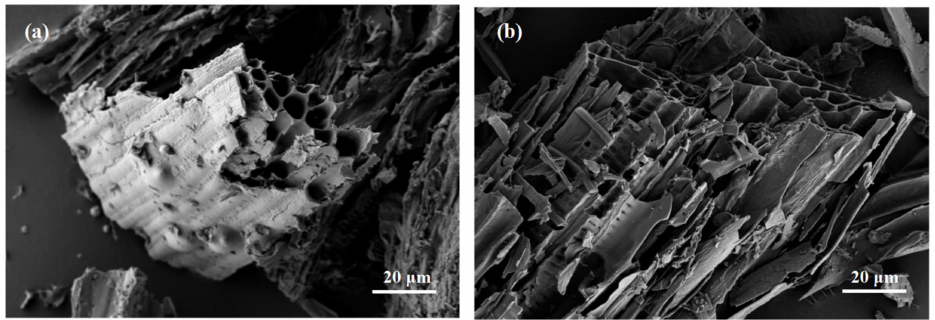
Figure 3. Scanning electron microscope of RSB 600 ( a ) and M-RSB 600 ( b ).